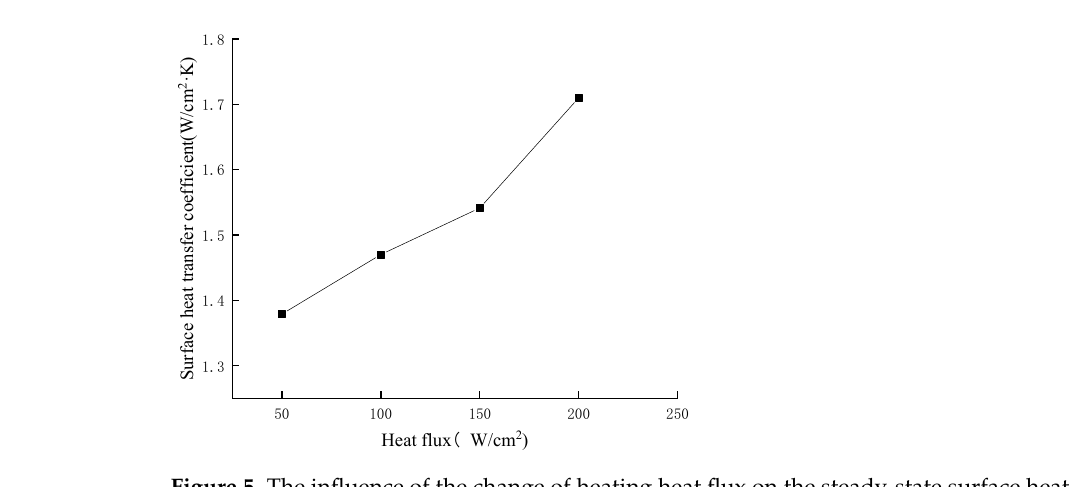
Figure 4. Transient surface heat transfer coefficient with change of heat flux at a flow rate of 40 L/h.